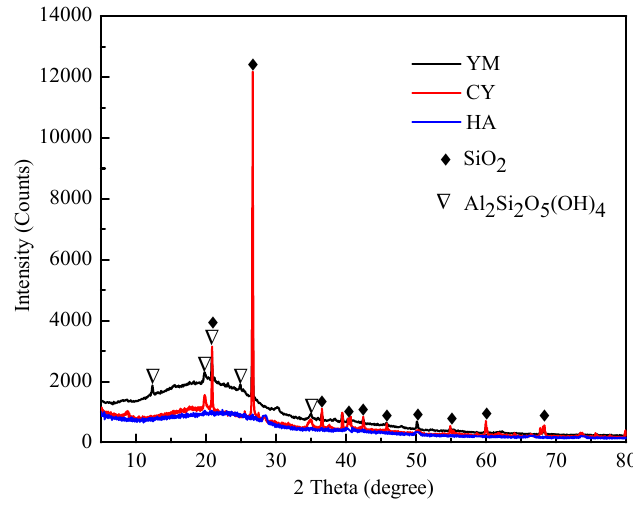
Figure 9. X-ray diffraction (XRD) patterns of the